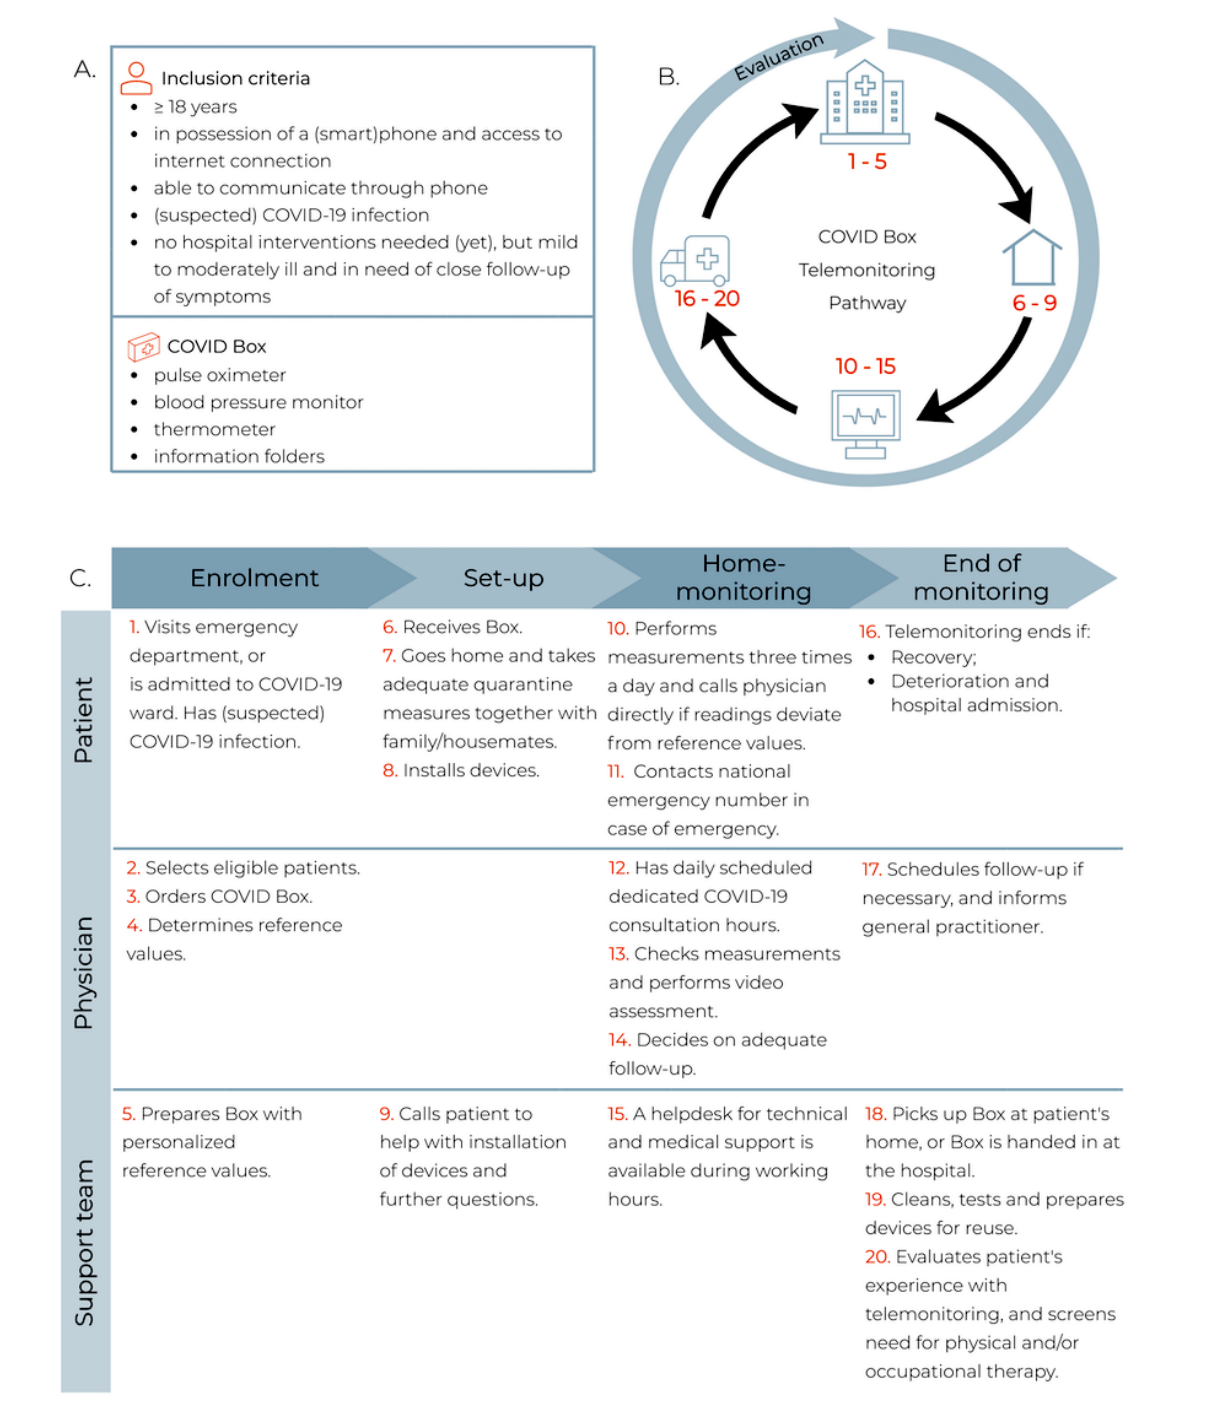
Figure 2. An example of a telemonitoring care pathway—the COVID Box. The COVID Box is a program developed by the Leiden University Medical Center to monitor patients with confirmed or suspected COVID-19 who have an increased risk of severe illness. (A) Inclusion criteria for the COVID Box; (B) general overview of the telemonitoring care pathway including continuous evaluation, where numbers 1-20 correspond to the steps described in (C), which provide a stepwise description of the COVID Box care